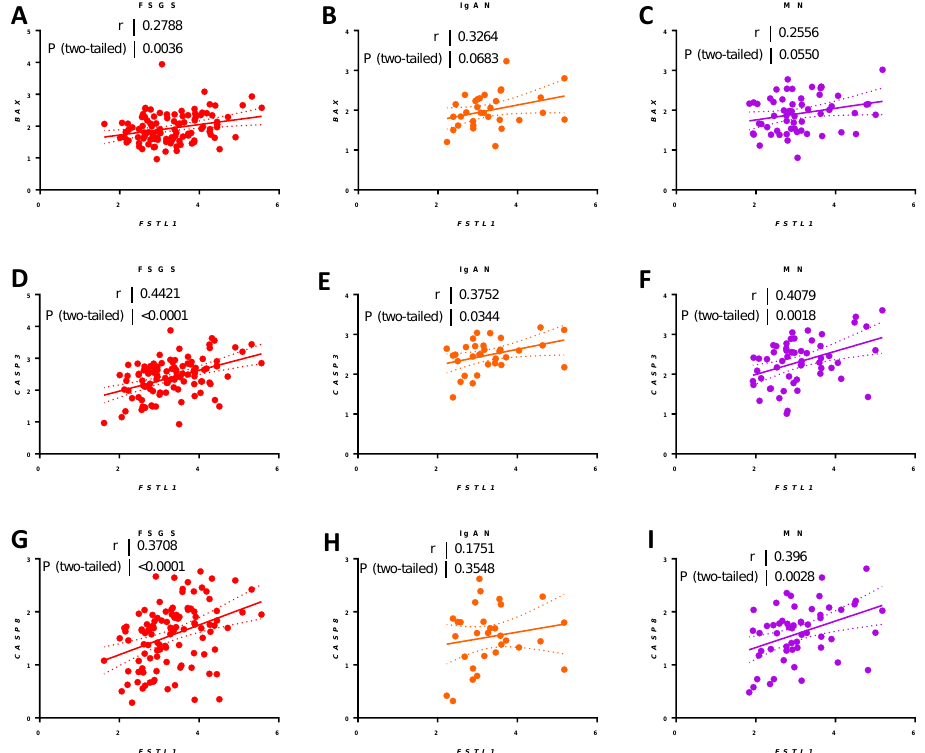
Figure 26. Relationship of FSTL1 mRNA levels to the Expression of Genes implicated in Apoptosis in FSGS (red), IgAN (orange), and MN (purple). BAX expression correlated to FSTL1 mRNA levels in FSGS ( A ), in IgAN ( B ), and MN ( C ). CASP3 expression correlated to FSTL1 mRNA levels in in FSGS ( D ), in IgAN ( E ), and MN ( F ). CASP8 expression correlated to FSTL1 mRNA levels in in FSGS ( G ), in IgAN ( H ), and MN ( I ). Pearson’s correlation coefficient ( r ) with two-tailed p values were calculated. Significance was determined as a p value of <0.05. Linear regression generated the line of best fit (solid lines) with 95% confidence intervals (dotted lines).